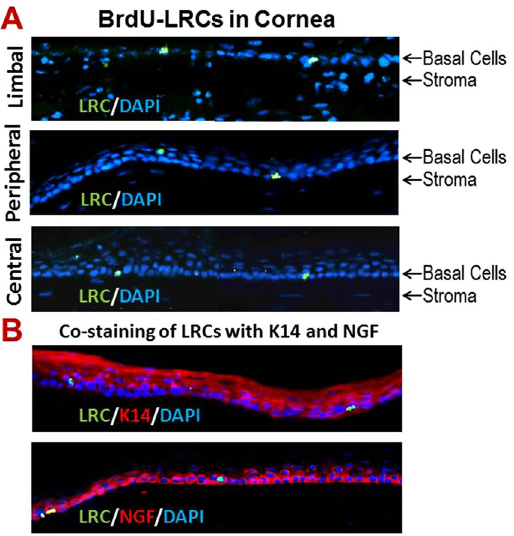
Figure 3. Label- retaining cells (LRCs) detected by BrdU immunofluorescent staining. ( A ) A number of slow cycling LRCs were detected in limbal (top panel), peripheral (middle panel) and central cornea (bottom panel) in C57BL/6 mice with 4 weeks chasing after BrdU injections. See method for detail. ( B ) Double staining of LRCs with epithelial cell marker K14 and stem cell marker NGF. Image magnification: 400 ×